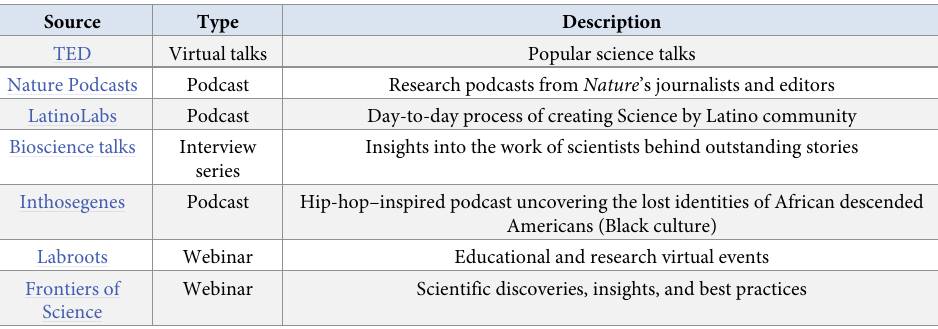
Table 1. Public speaking